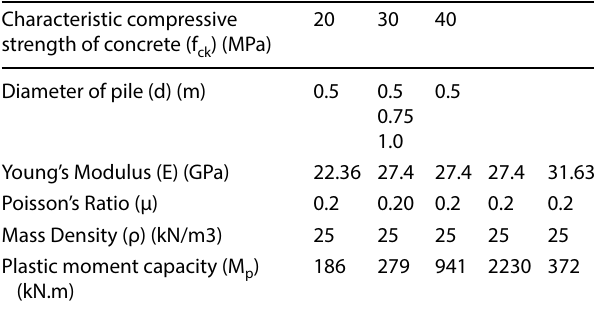
) of piles with various all